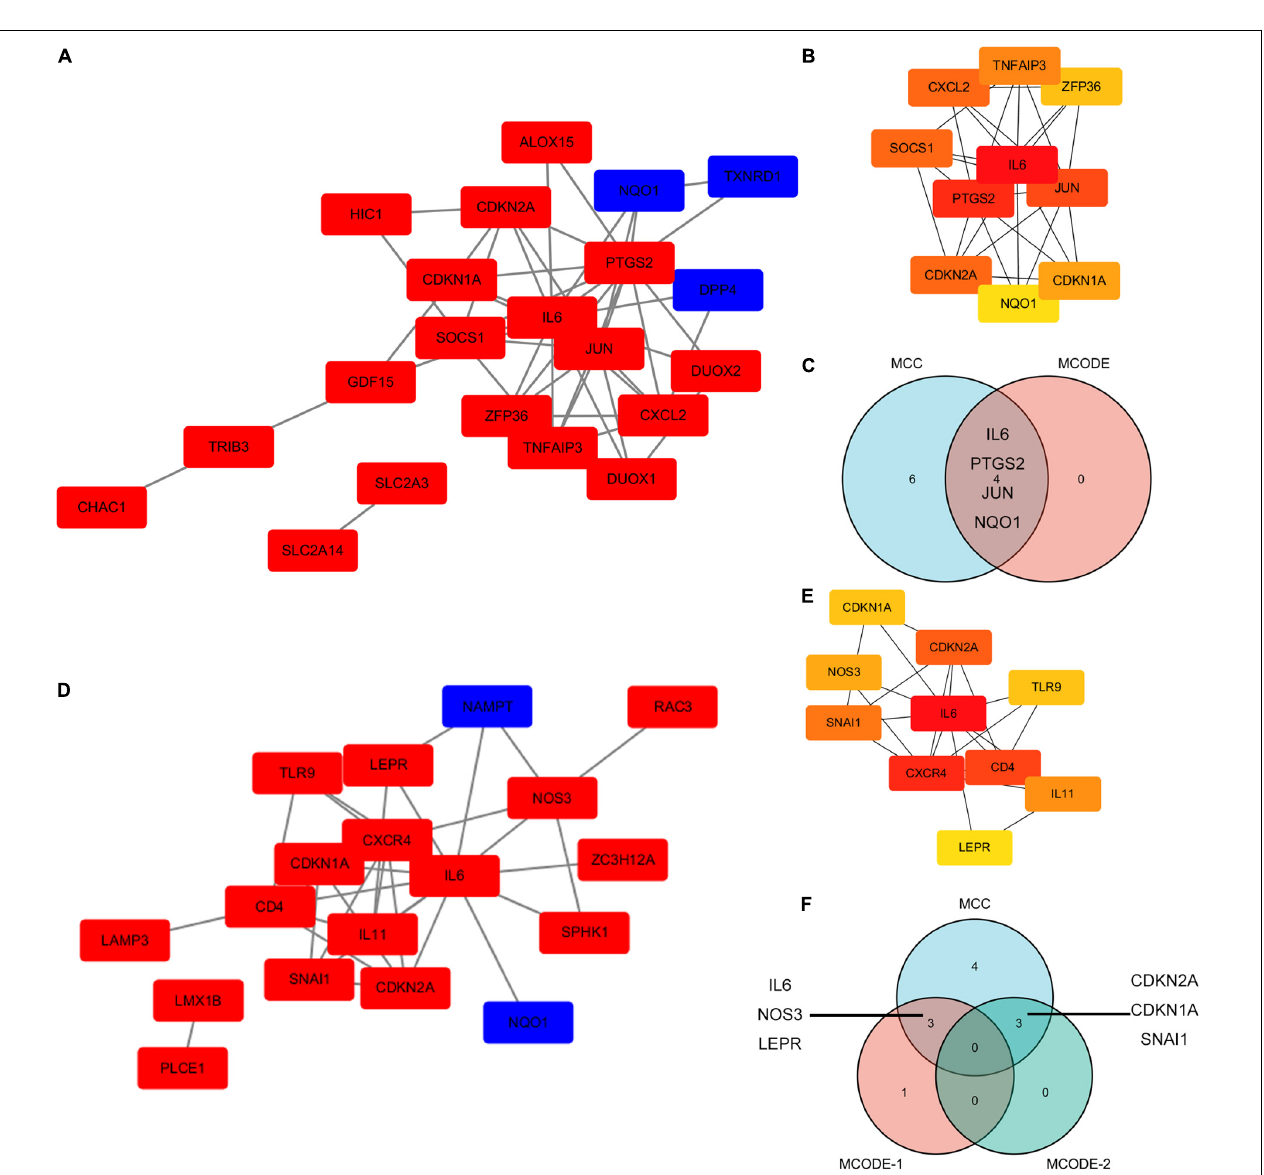
FIGURE 6 | The PPI analysis of ferroptosis-related DEGs and autophagy-related DEGs. (A) The PPI analysis of ferroptosis-related DEGs. Red, upregulated genes; blue, downregulated genes. (B) The top10 ferroptosis-related DEGs using MCC. (C) A Venn diagram of ferroptosis-related DEGs using MCC and MCODE analysis module. (D) The PPI analysis of autophagy-related DEGs. Red, upregulated genes; blue, downregulated genes. (E) The top 10 autophagy-related DEGs using MCC. (F) A Venn diagram of autophagy-related DEGs using MCC and the MCODE analysis module.